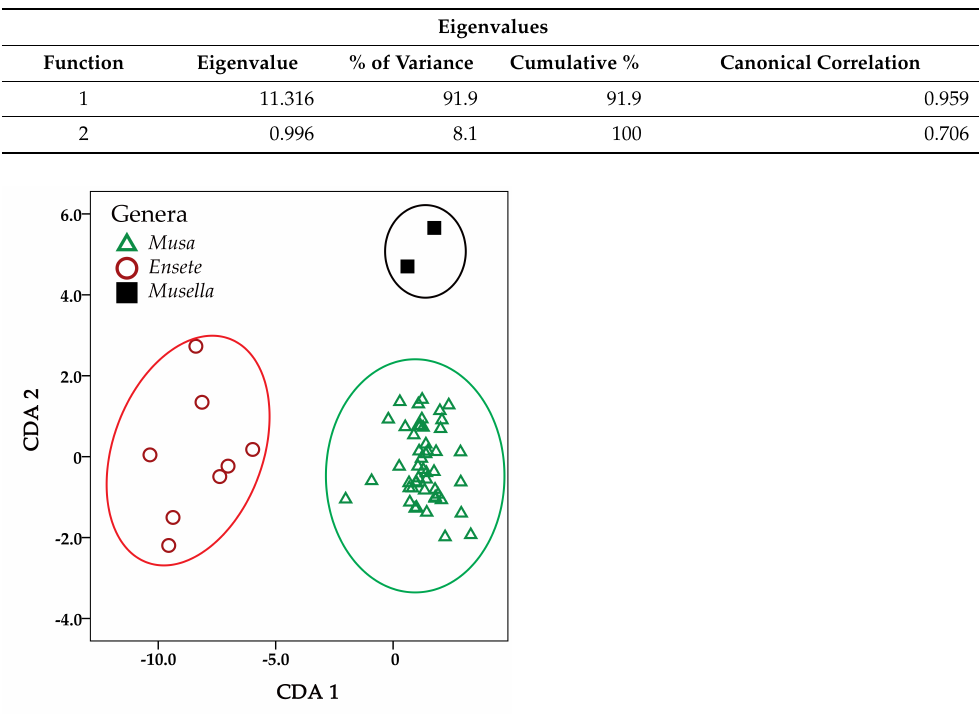
Table 3. Summary of canonical discriminant function of four clustering groupings of 59 OTUs between Musa , Ensete and Musella within Musaceae showed percent of variance in analysis.